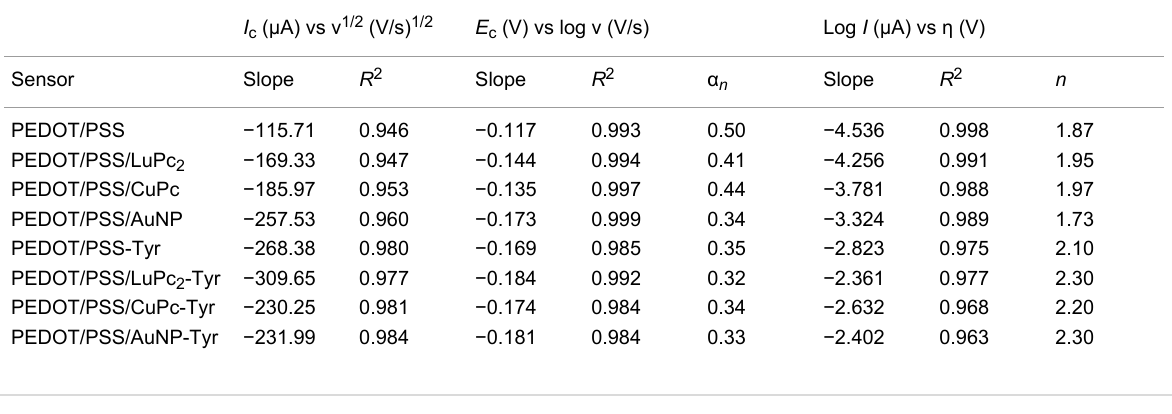
Table 3: Relationship between scan rate in sensors immersed in catechol 10 − 3 mol·L − 1 calculated in the cathodic peak.